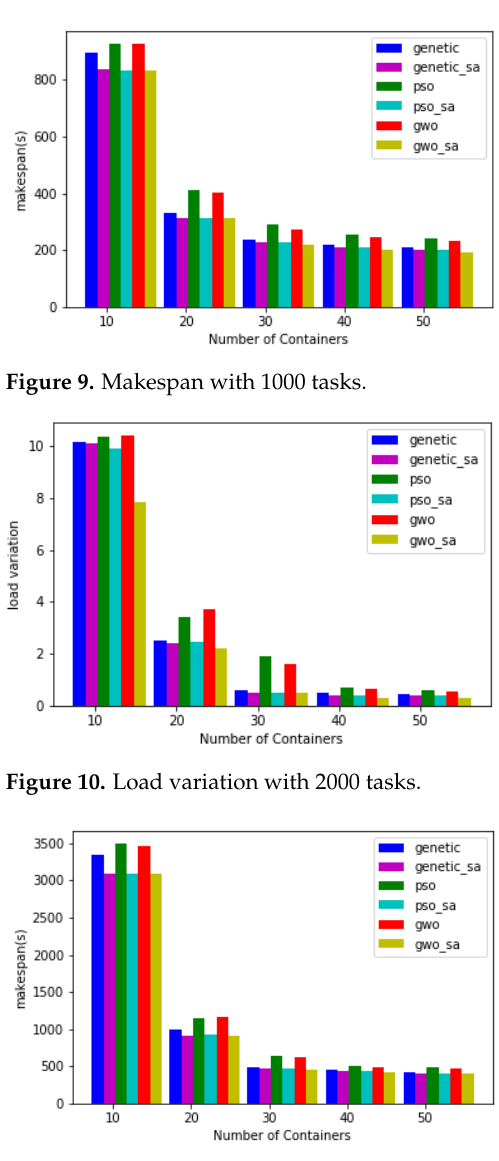
Figure 11. Makespan with 2000 tasks.